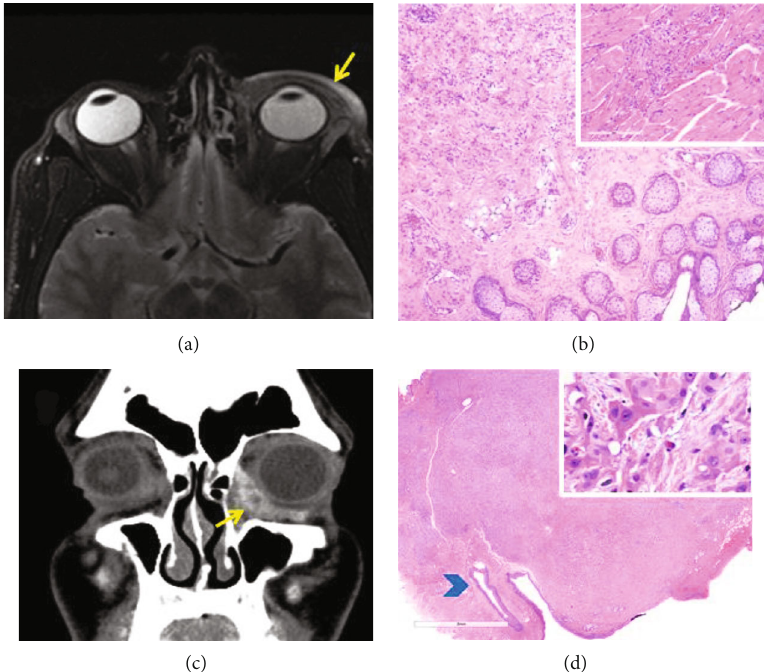
Figure 3: Case 3: (a) MRI depicting an in fi ltrative lesion involving pre- and postseptal regions of the left upper and lower eyelids (arrow); (b) tarsus di ff usely in fi ltrated by neoplastic cells (H&E 4x). Inset: higher magni fi cation of cords of neoplastic cells in fi ltrating skeletal muscle (20x). Case 4: (c) CT scan shows enhancing and in fi ltrative mass along the inferomedial aspect of the left anterior orbit; (d) panoramic view shows neoplastic cells forming a mass lesion adjacent to the punctum (arrowhead) and in fi ltrating caruncle (H&E). Inset: higher magni fi cation depicting tumor cells with vesicular nuclei, large nucleoli, and eosinophilic cytoplasm with intracytoplasmic vacuolization (H&E 20x). Table 2: Immunohistochemical results for four SRC/Histiocytoid carcinomas of the eyelid. Antibody Case 1